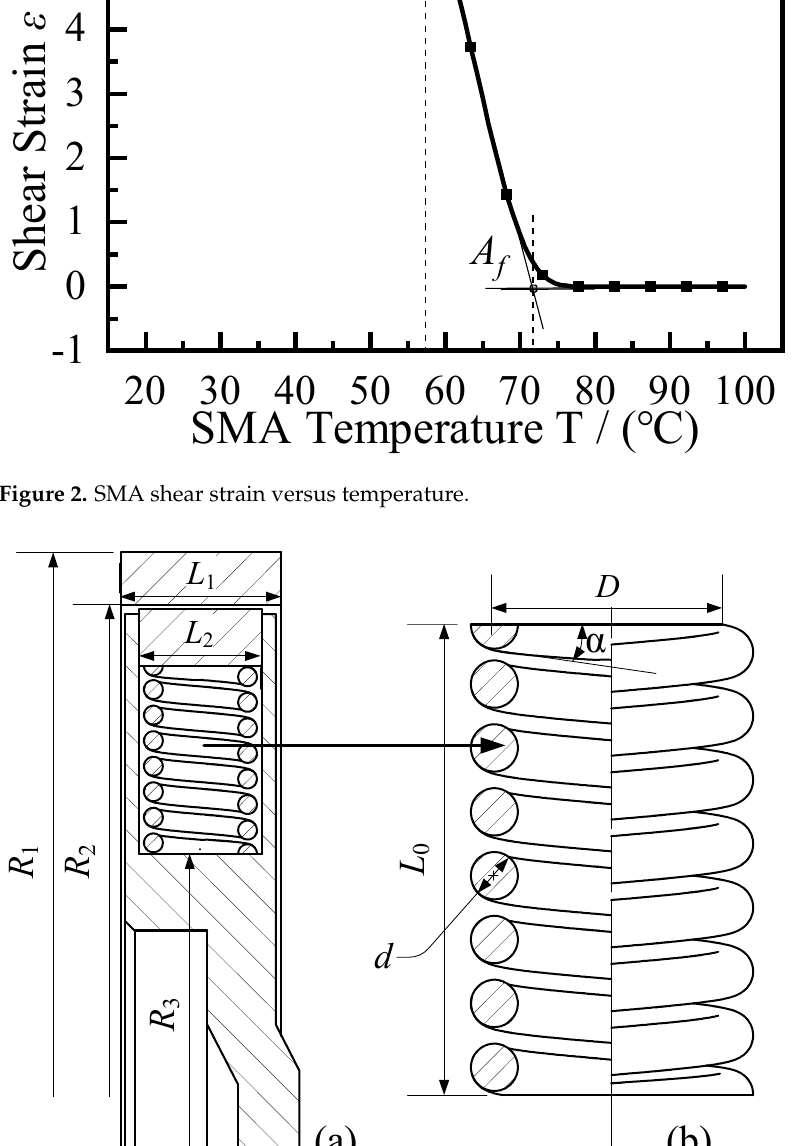
Figure 2. SMA shear strain versus temperature.